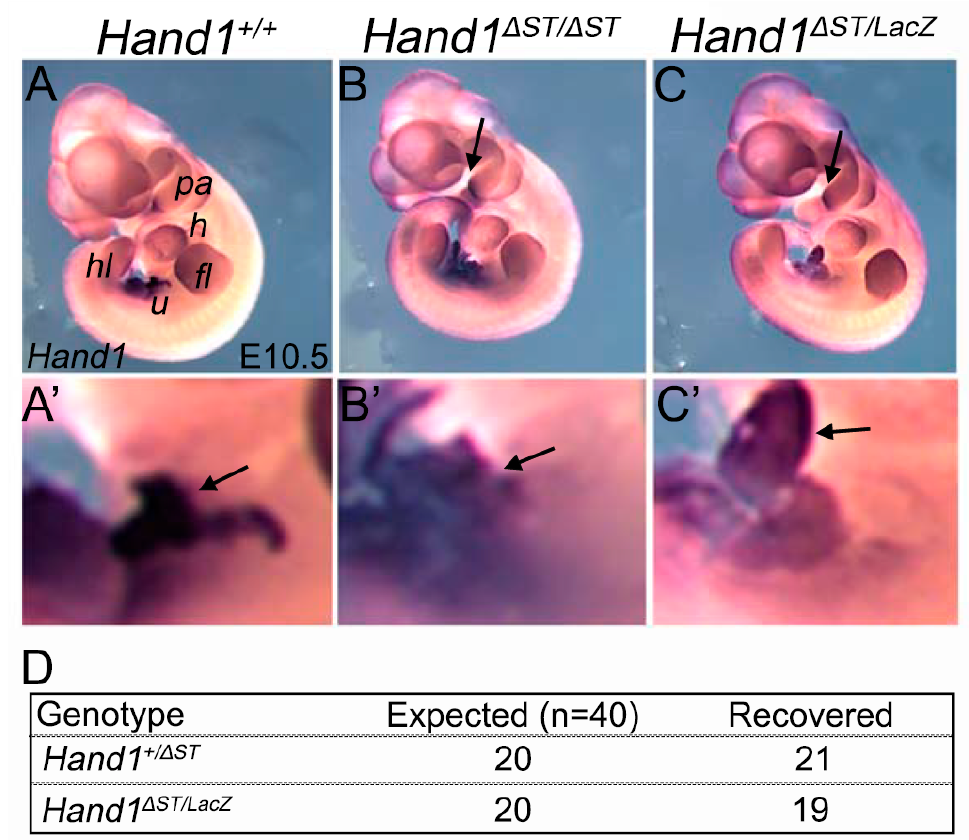
Figure 2. Loss of a Hand1 Allele over the ST Enhancer knockout does not lead to embryonic lethality. ( A – C ) Whole mount in-situ hybridization (WISH) at E9.5 for Hand1 mRNA in Hand1 +/+ , Hand1 ∆ ST/ ∆ ST , and Hand1 ∆ ST/LacZ embryos showing no qualitative or spatial change in Hand1 mRNA levels. Arrows indicating pharyngeal arch expression of Hand1 in Hand1 ∆ ST/ ∆ ST and Hand1 ∆ ST/LacZ embryos. N = 5 embryos for all genotypes. pa, pharyngeal arches; h, heart; fl, forelimb; hl, hindlimb; u, umbilicus. ( A ’– C ’) Umbilicus region expression of Hand1 in WISH embryos. ( D ) Table showing expected and recovered genotypes at postnatal day 10 from Hand1 ∆ ST/ ∆ ST and Hand1 LacZ/+ parental